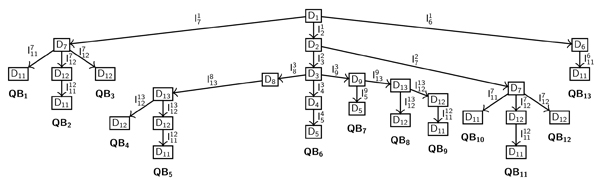
Behavior tree. Behavior tree rooted in D1, BT(D1), obtained by the simulation of the model Eqs.(7) with initial condition ⟨D1, I0⟩, where I0 is defined by Eq. (8). Each branch in the tree defines a qualitative trajectory that occurs when the inequalities that characterize each path in the branch hold.